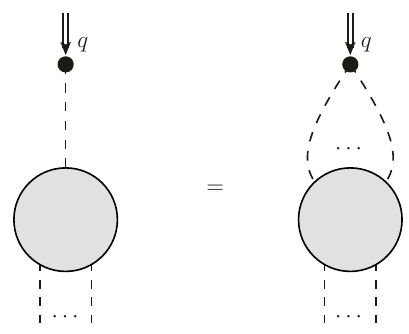
Figure 3 . A graphic representation of eq. (2.31), where the grey blobs denote collections of NLSM Feynman diagrams, while the black dot indicates the insertion of the current J carrying the momentum q , with the l.h.s. given by the one-particle pole in J , and the r.h.s. given by ˜ J .